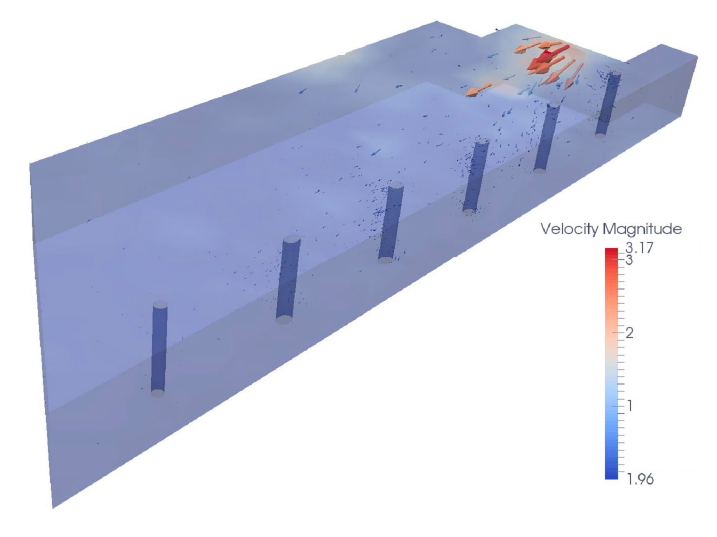
Figure 3. Room and velocity vector coloured and scaled in terms of the velocity norm for the case studied with maximum velocity value for inflow velocity.